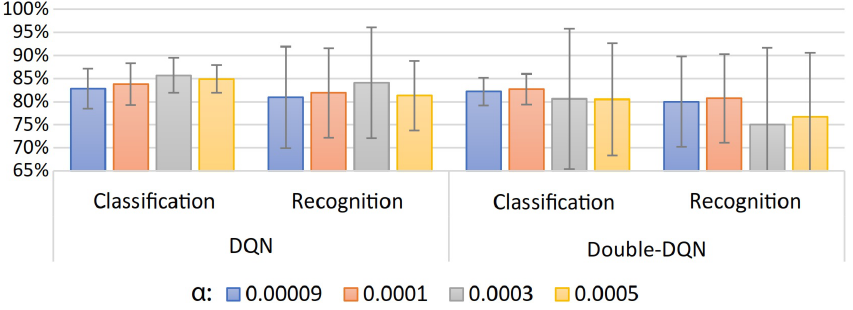
Figure 7. User-specific HGR model classification and recognition accuracy results for 20 users with different values of learning rate ( α ) for both DQN and Double-DQN.